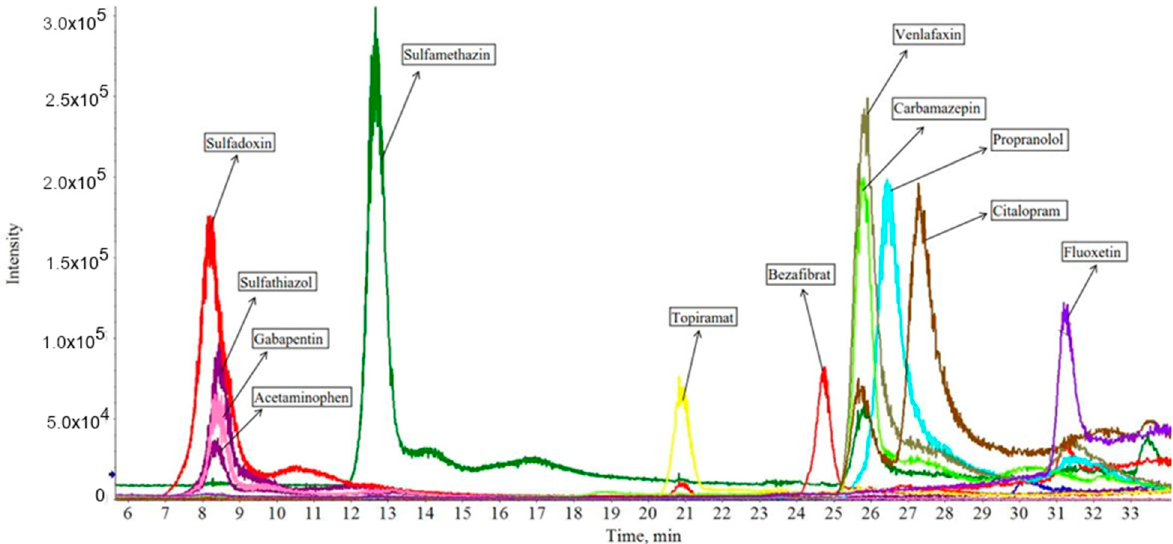
Figure 2. Chromatogram of XB standards. Overview of retention times and intensities of the identified standards based on the Extracted Ion Chromatogram.